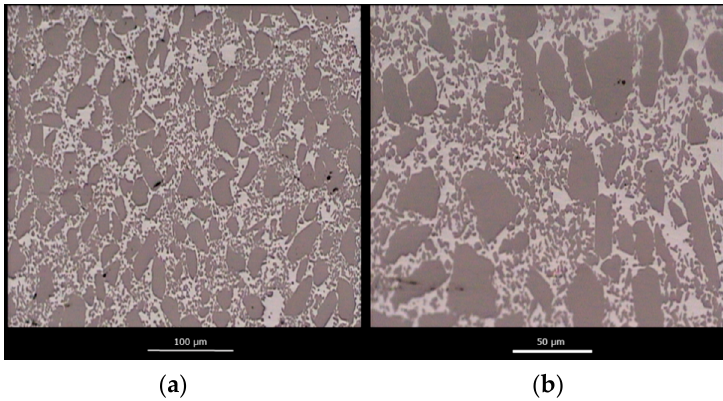
Figure 7. Representative optic micrographs of a fully infiltrated SiC p / Si composite material with a low ( a ) and a high ( b ) magnification.